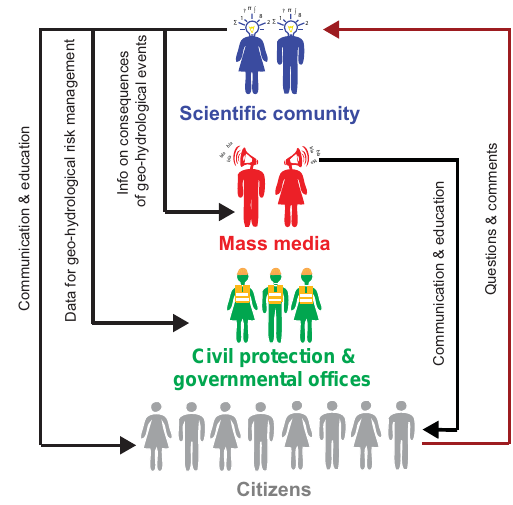
Figure 1. The POLARIS communication